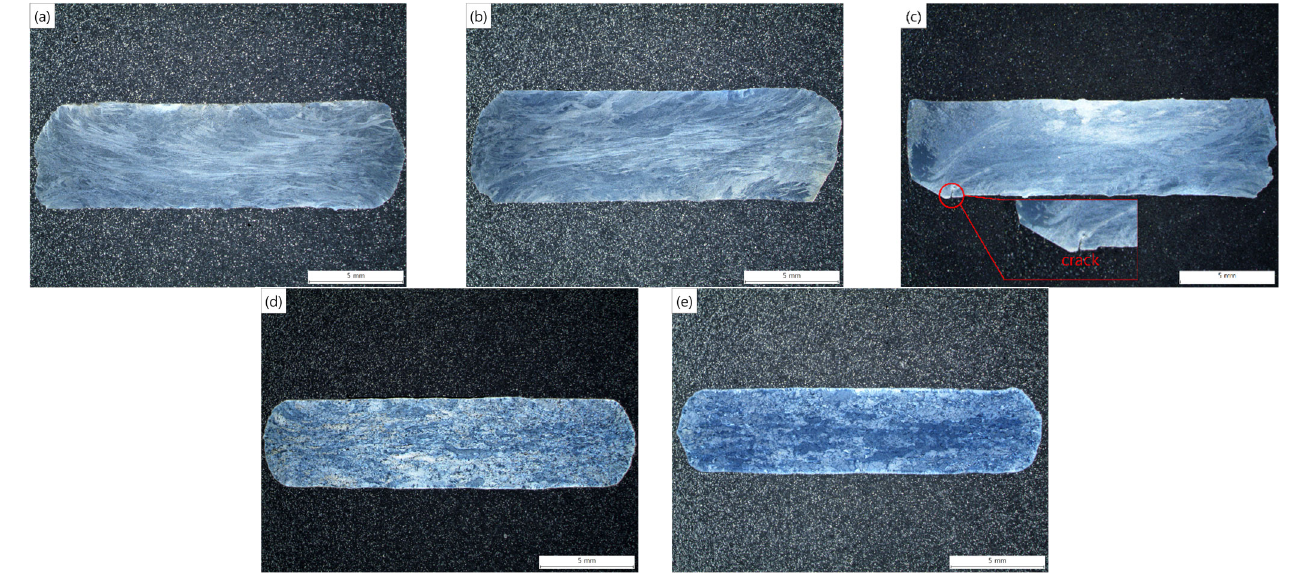
Figure 12. Macrostructures of the cross ‐ sectioned areas according to each condition after high ‐ temperature compression of Ti ‐ 6Al ‐ 4V alloy; ( a ) 800 °C, 1 (cid:3400) 10 (cid:2879)(cid:2870) /s , ( b ) 800 °C, 1 (cid:3400) 10 (cid:2868) /s , ( c ) 850 °C, 1 (cid:3400) 10 (cid:2879)(cid:2870) /s , ( d ) 1050 °C, 1 (cid:3400) 10 (cid:2879)(cid:2870) /s , ( e ) 1100 °C, 1 (cid:3400) 10 (cid:2879)(cid:2870) /s .